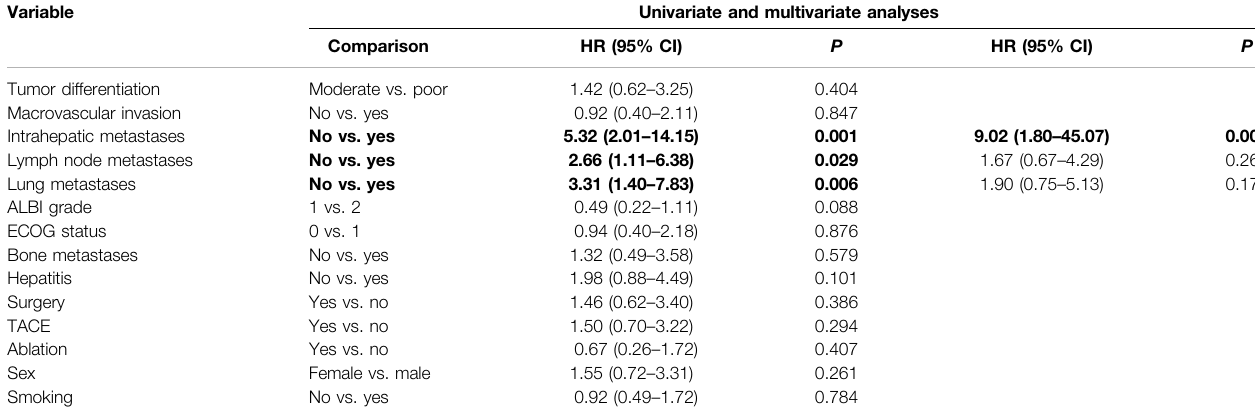
TABLE 5 | Univariate and multivariate analyses of prognostic factors on overall survival (OS) in 40 patients with advanced ICC after chemotherapy failure. Variable Univariate and multivariate analyses